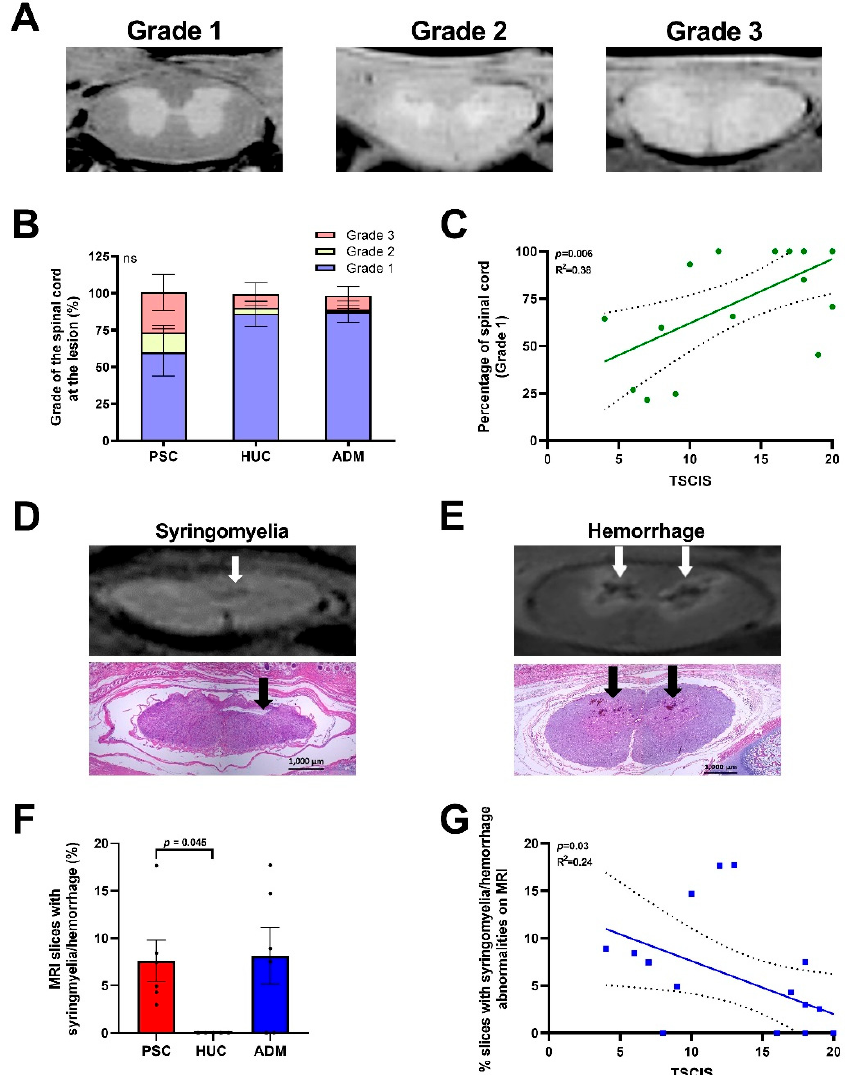
Figure 4. Radiological findings in terms of neurological outcomes. MRI evidence of lower pathology grades with increased TSCIS scores, and the presence of syringomyelia affecting neurological out- comes negatively. ( A ) Representative images of MRIs graded as either Grade 1 (slight distortion), Grade 2 (moderate distortion), or Grade 3 (severe distortion) by capability of distinguishing gray from white matter. ( B ) Grade of the lesion for all defect repair groups are provided as a percentage. ( C ) Simple linear regression of the percentage of Grade 1 per spinal cord is shown as a function of the TSCIS score. Confidence intervals at 95% are provided. A p = 0.05 was considered significant. ( D ) MRI showing fluid collection at the central canal (white arrow) and the corresponding H&E image showing syringomyelia (black arrow) with lining extending into the central canal. ( E ) Diffuse hemorrhage seen in a spinal cord on MRI (white arrow) was confirmed using H&E histology (white arrow). ( F ) Quantitative comparison of syringomyelia/hemorrhage for the percentage of sections per lamb on MRI noted in the spinal cords. ( G ) Association of the percentage of slices with syringomyelia/hemorrhage and TSCIS score as seen on H&E sections were analyzed by simple linear regression using 95% confidence intervals, where p = 0.05 was considered significant. p -values for continuous data were determined by ANOVA, Kruskal–Wallis test using Dunn’s multiple compar- isons test.